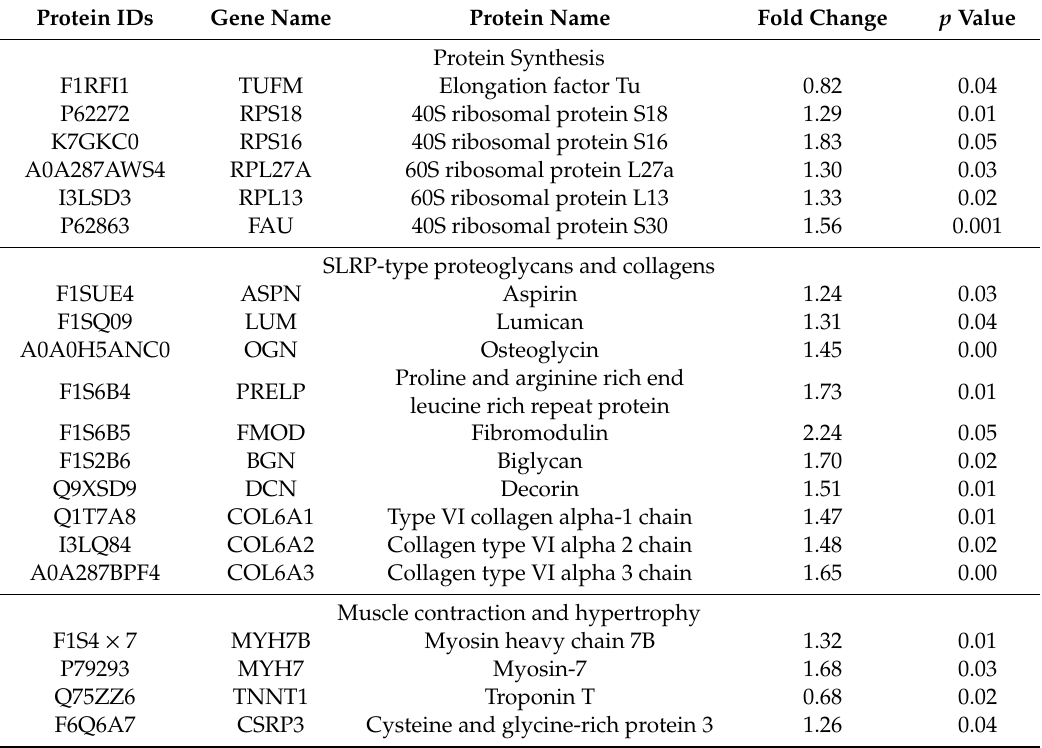
Table 7. Di ff erentially expressed proteins related to muscle growth in pigs.